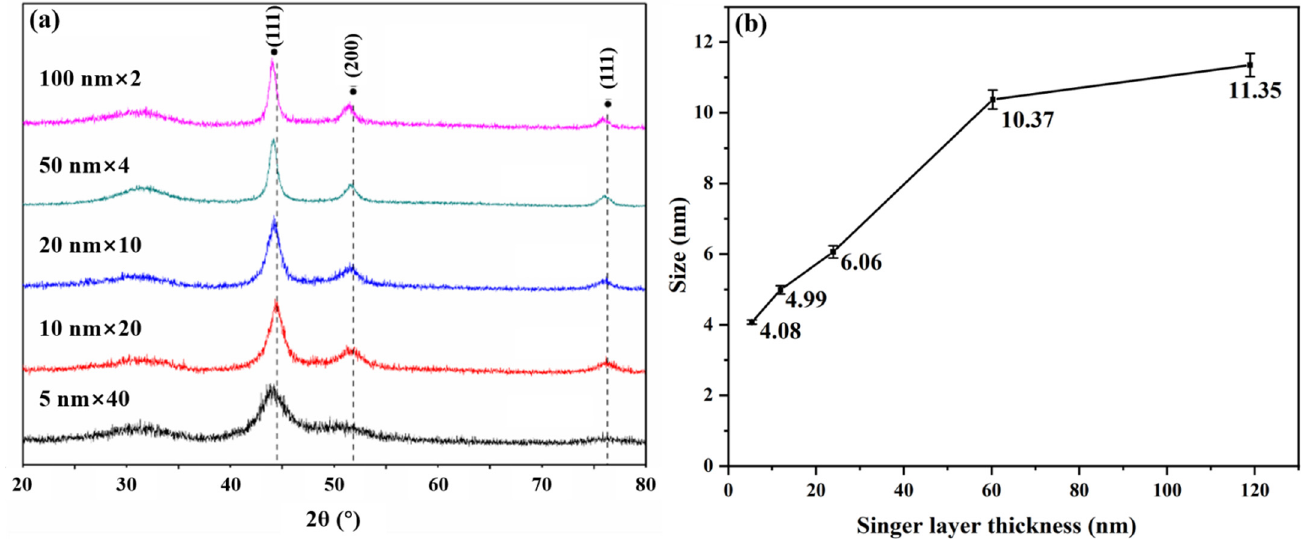
Figure 5. ( a ) The GIXRD spectra of irradiated amorphous ZrC/nanocrystalline Ni multilayer. ( b ) The grain size changing with layer thickness after